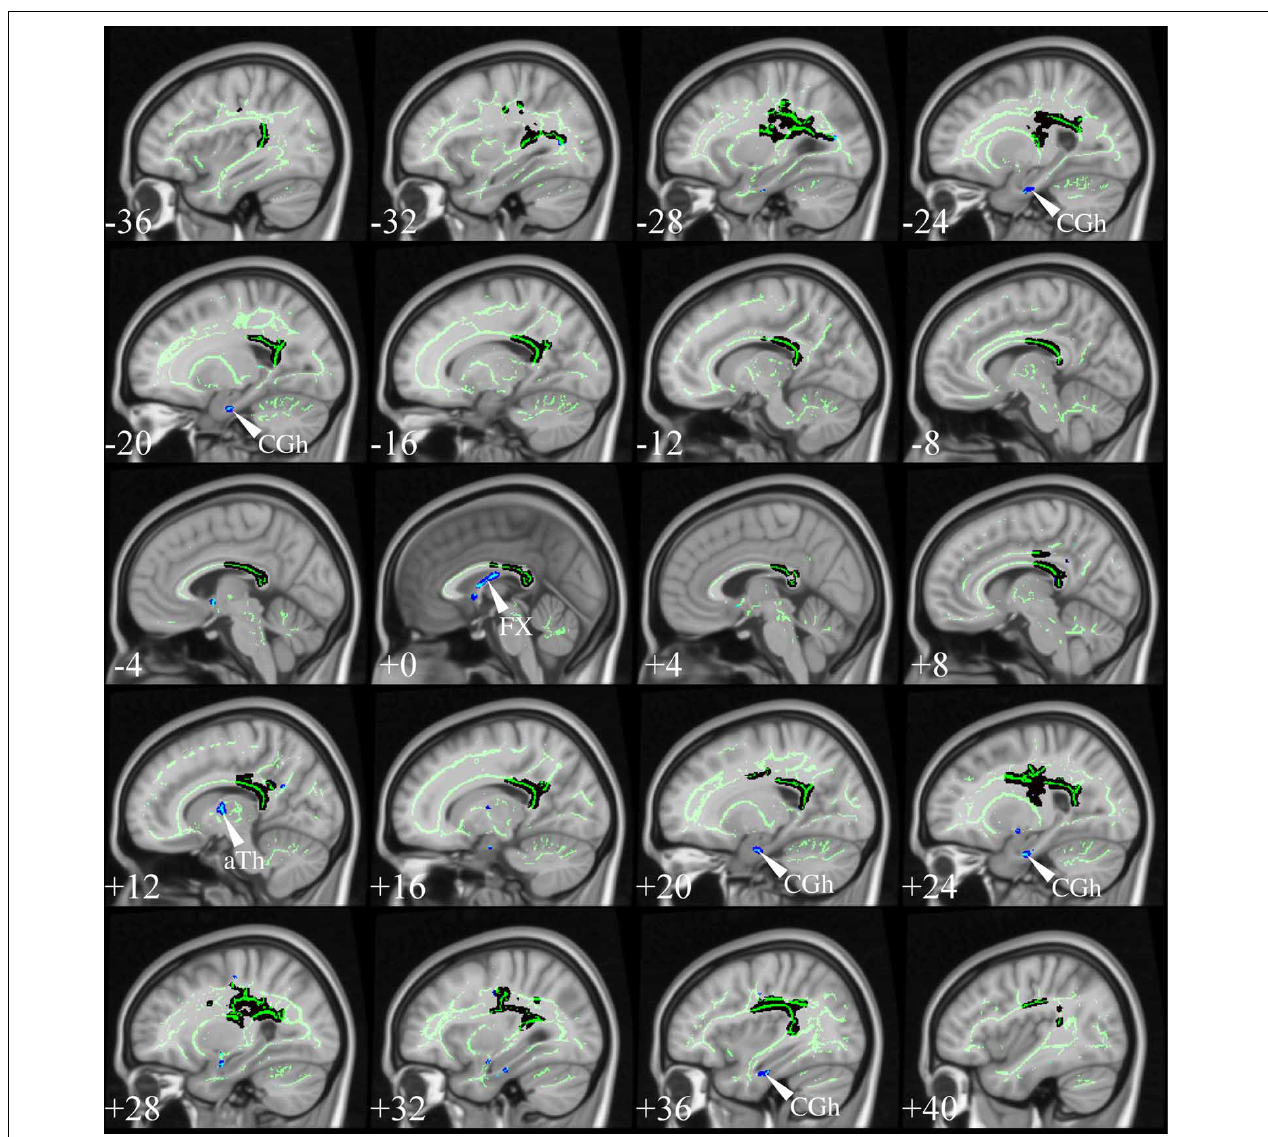
FIGURE 10 | TBSS in very mild AD. TBSS results for N = 21 very mild AD patients (age: 72 ± 5, < MMSE > = 26 ± 2) vs. N = 26 matched controls (age: 68 ± 6) (Acosta-Cabronero et al., 2012). The patient group included N = 16 subjects who were scanned with a diagnosis of mild cognitive impairment but were subsequently shown to have probable AD with longitudinal follow-up. Black clusters denote increased λ 1 in patients